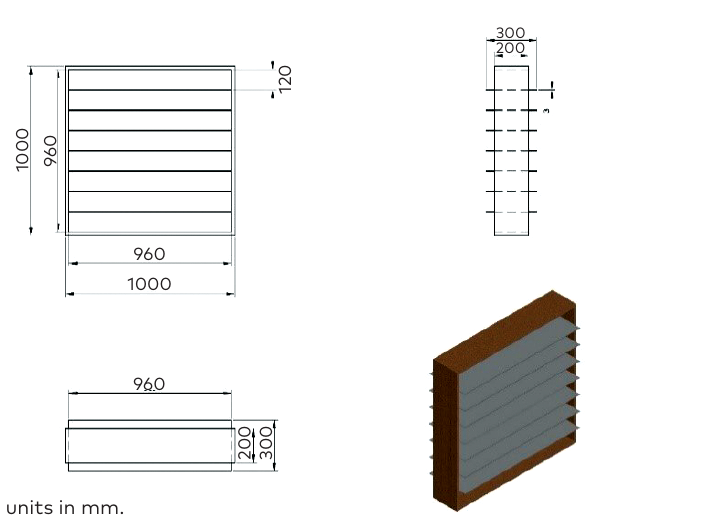
Note: units in mm. Figure 3. The design of the louvred noise barrier for laboratory sound attenuation tests